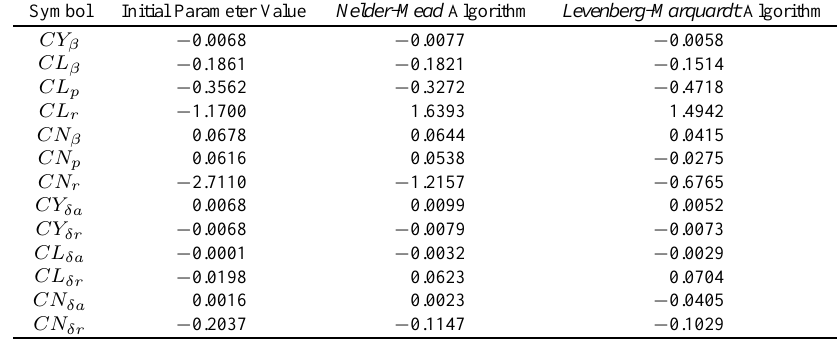
Table 1 Parameter estimation of the aerodynamic and control derivatives